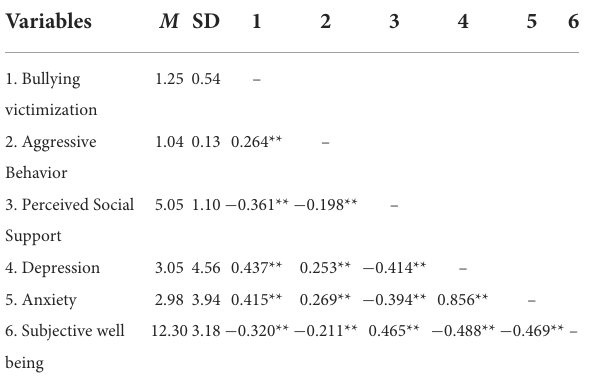
TABLE 2 Correlation analysis of study